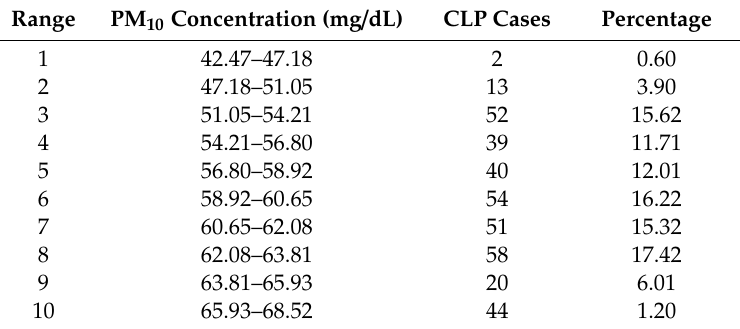
Table 6. CLP cases and PM 10 concentration.